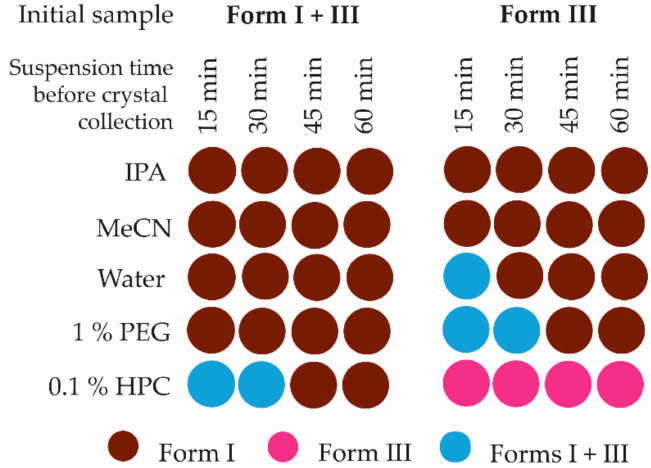
Figure 5. Polymorphic composition of the solid phase after selected times during SMPT kinetic experiments at 25 ◦